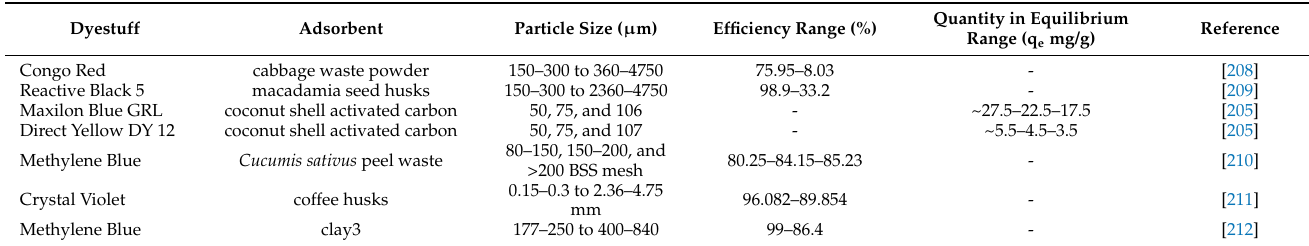
Figure 6, from the study of Shahul K. Hameed et al. [213], represents the effect of particle size on adsorption efficiency, where chromotrope dye was adsorbed on the surface of activated carbons obtained from the seeds of various